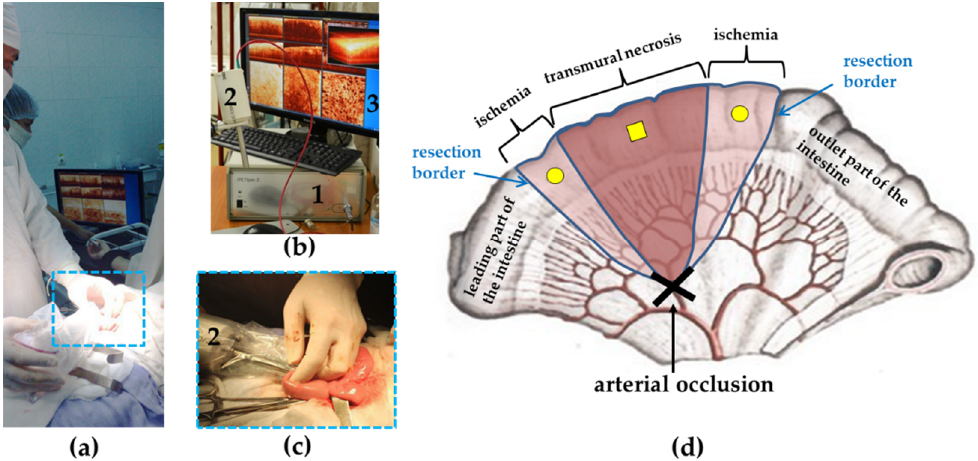
Figure 1. The procedure for intraoperative small intestine visualization using multimodal optical coherence tomography (MM OCT). ( a ) General overview of the trans-serous MM OCT study; ( b ) MM OCT system (1) with probe (2) and an example of data set acquired after tissue scanning (3); ( c ) the probe (2) in a sterile sheath is placed on the surface of the normal ileum; ( d ) diagram of the MM OCT study of ischemic bowel: square mark—point of the OCT probe localization on the anesthetized part of the intestine, round marks—points from which MM OCT images were obtained from the ischemic areas of the intestine to be